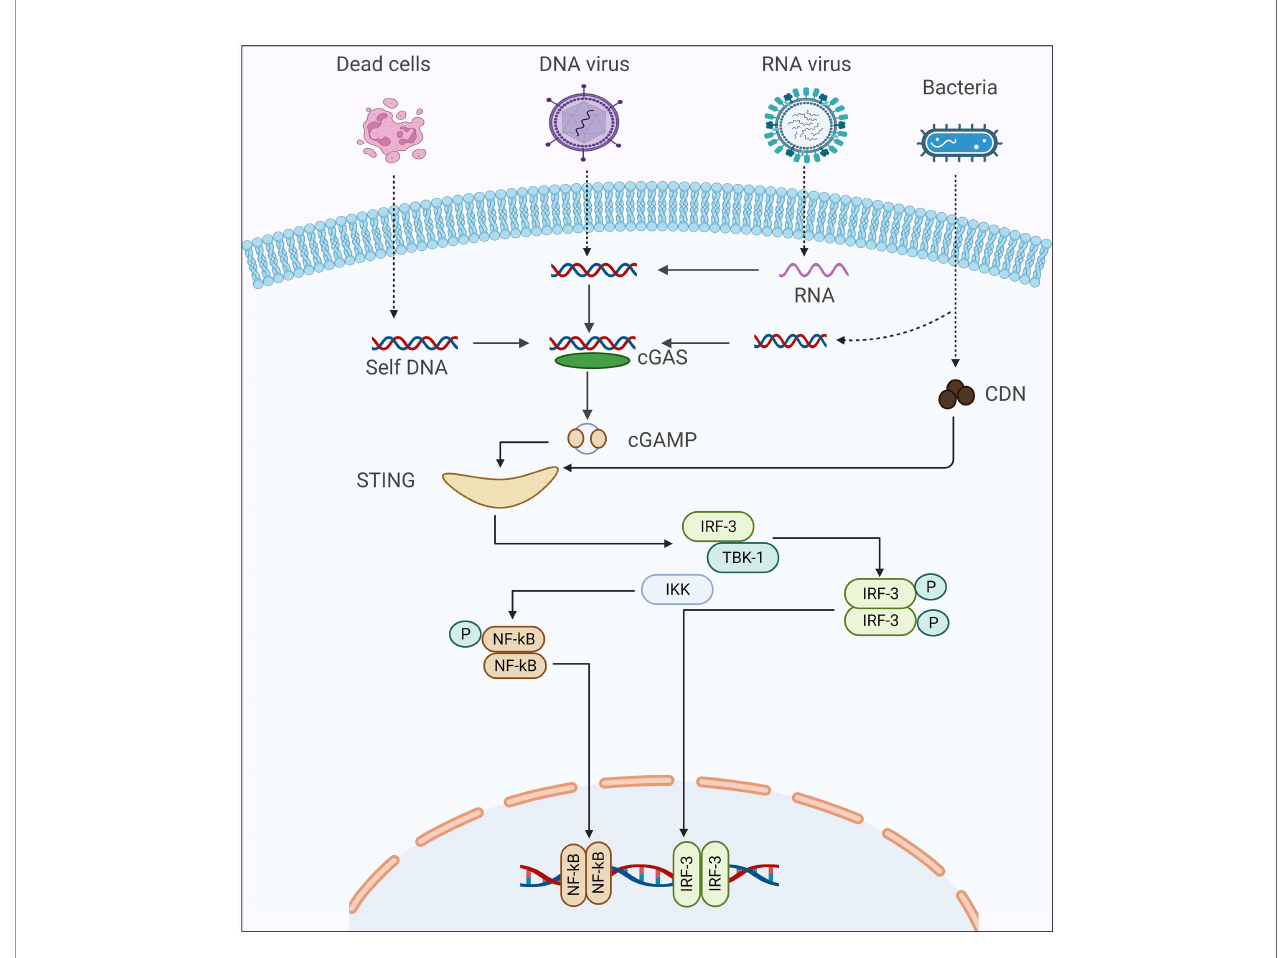
FIGURE 1 | The Schematic presentation of cGAS-STING signaling cascade activation in response to different kinds of